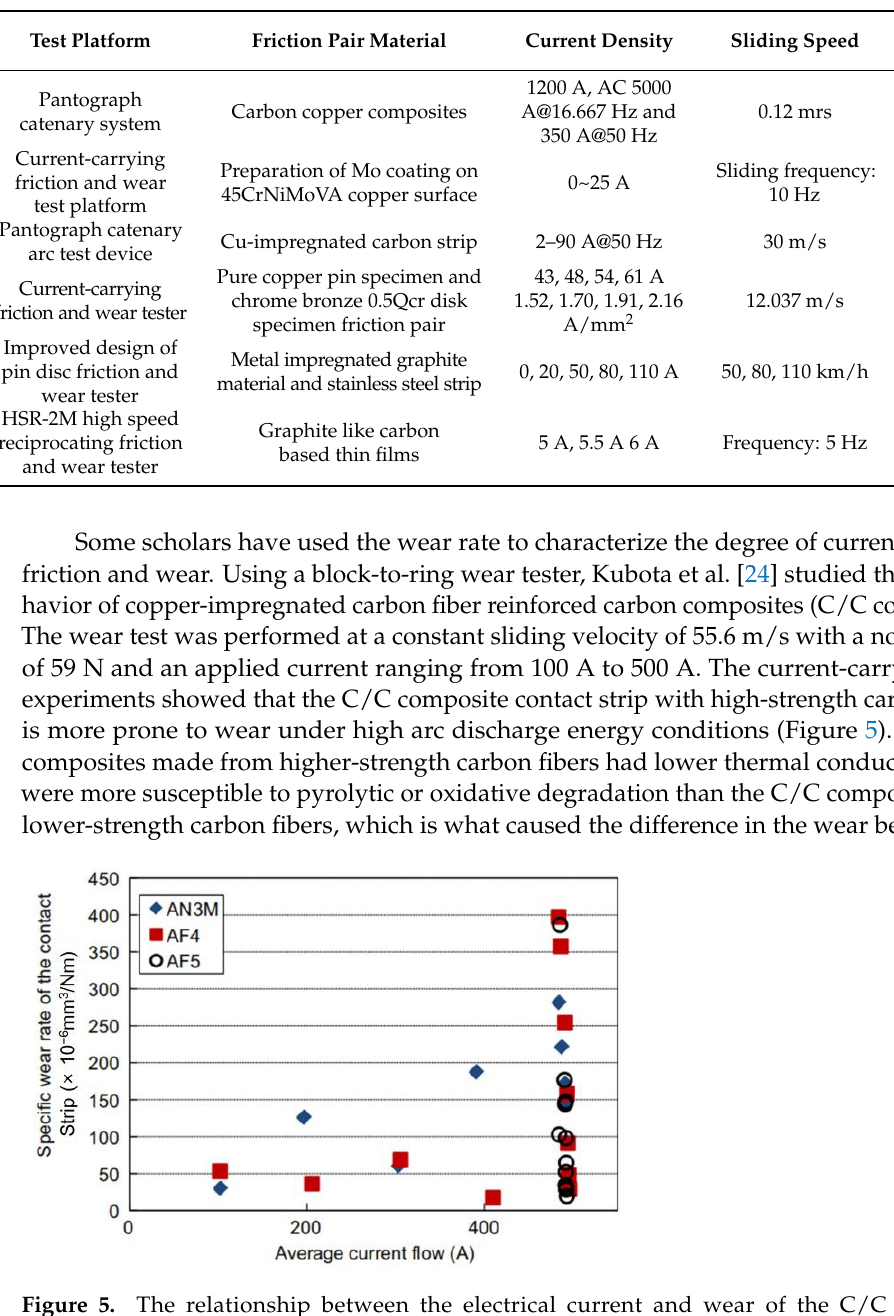
Figure 5. The relationship between the electrical current and wear of the C/C composite contact strips